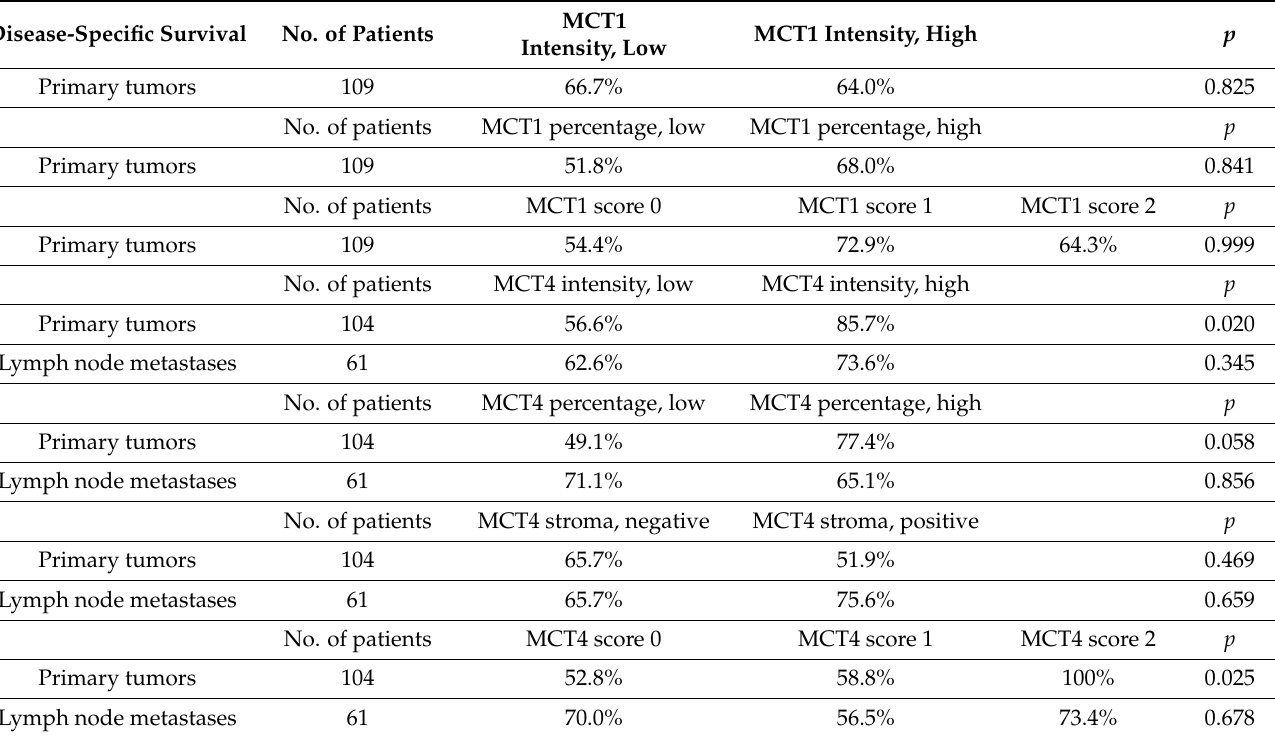
Table 3. Disease-specific survival rates based on MCT1 and MCT4 stainings (intensity, percentage, MCT score, and stromal staining) in both primary tumors and lymph node metastases. Lymph node metastases showed negative MCT1 staining and therefore these are not